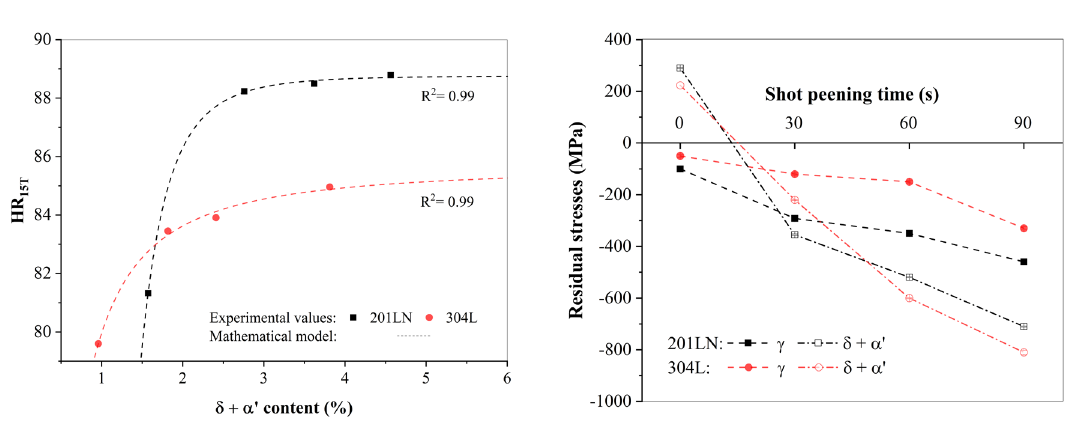
Figure 5. Correlation between delta ferrite plus martensite content and surface hardness for 201LN and 304L steels.